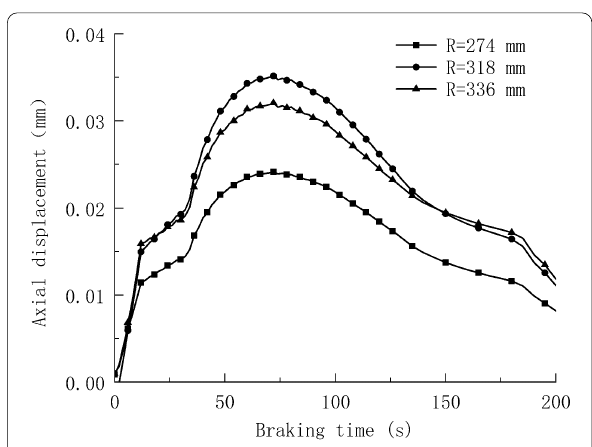
Figure 12 The axial displacement of the bolt hole on the contact surface between the disc body and the wheel changes with